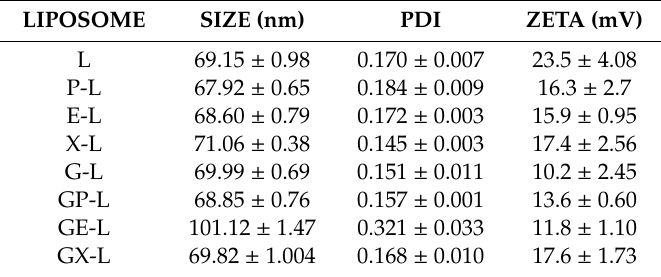
Figure 1. Characterization of liposomes: hydrodynamic diameter histograms of empty (L) or liposomes containing paclitaxel (P-L), erlotinib (E-L), XL-184 (X-L), gemcitabine (G-L) and combination of gemcitabine plus paclitaxel (GP-L), gemcitabine plus erlotinib (GE-L), and gemcitabine plus XL-184 (GX-L) liposomes obtained from dynamic light scattering (DLS) intensity measurements. All the measurements were performed in deionized water at 25 °C. Table 1. Hydrodynamic diameter, polydispersity index (PDI), and zeta potentials of respective liposomes.